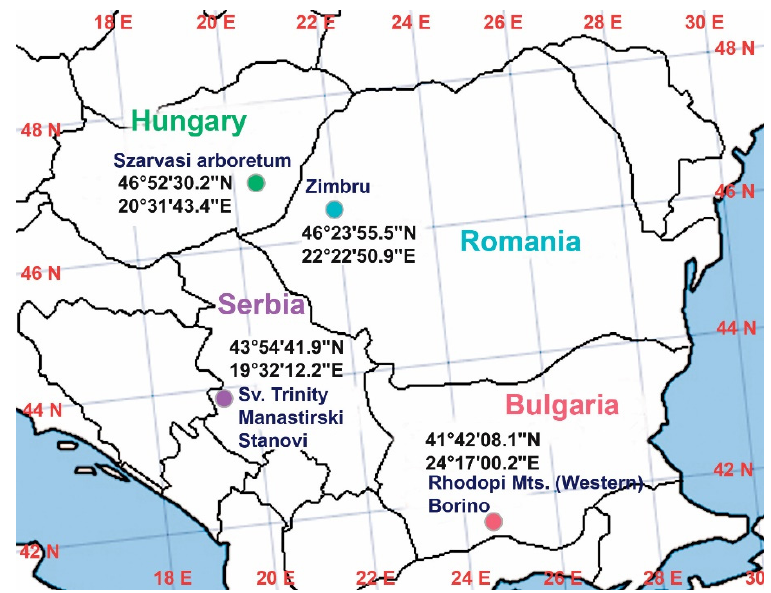
Figure 9. Collection points of Ilex aquifolium samples. Romania, Zimbru Reservation, “Dosul Lau- rului” GPS coordinates: 46°23 ′ 55.5 ″ N, 22°22 ′ 50.9 ″ E; Hungary, Szarvasi arboretum: 46°52 ′ 30.2 ″ N, 20°31 ′ 43.4 ″ E; Bulgaria, Borino, Rhodopi Mts.: 41°42 ′ 08.1 ″ N, 24°17 ′ 00.2 ″ E; and Serbia, middle of the Mala Reka region, Sv. Trinity—Manastirski Stanovi: 43°54 ′ 41.9 ″ N, 19°32 ′ 12.2 ″ E. The color codes on all graphical depictions are as follows: light blue: Romania; green: Hungary; purple: Serbia; and red: Bulgaria.